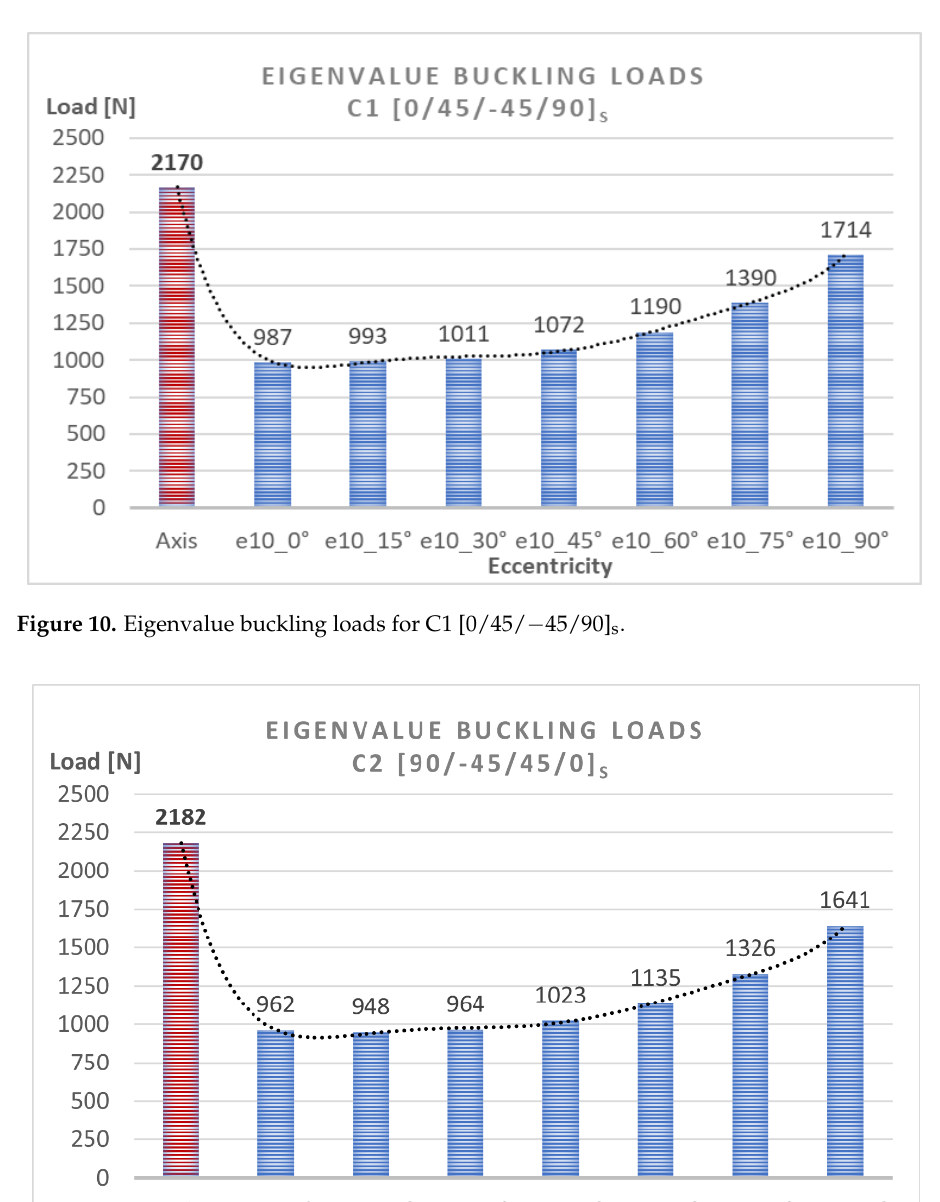
Figure 11. Eigenvalue buckling loads for C2 [90/ − 45/45/0] s .